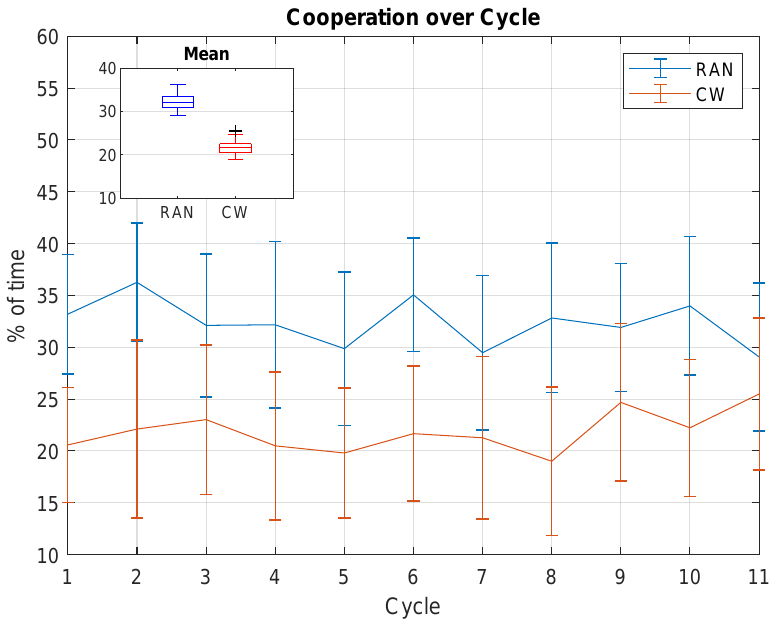
Figure 14. Mean percentage of time when hands cooperate, which means that both act to rotate the handlebar in the same direction (clockwise or